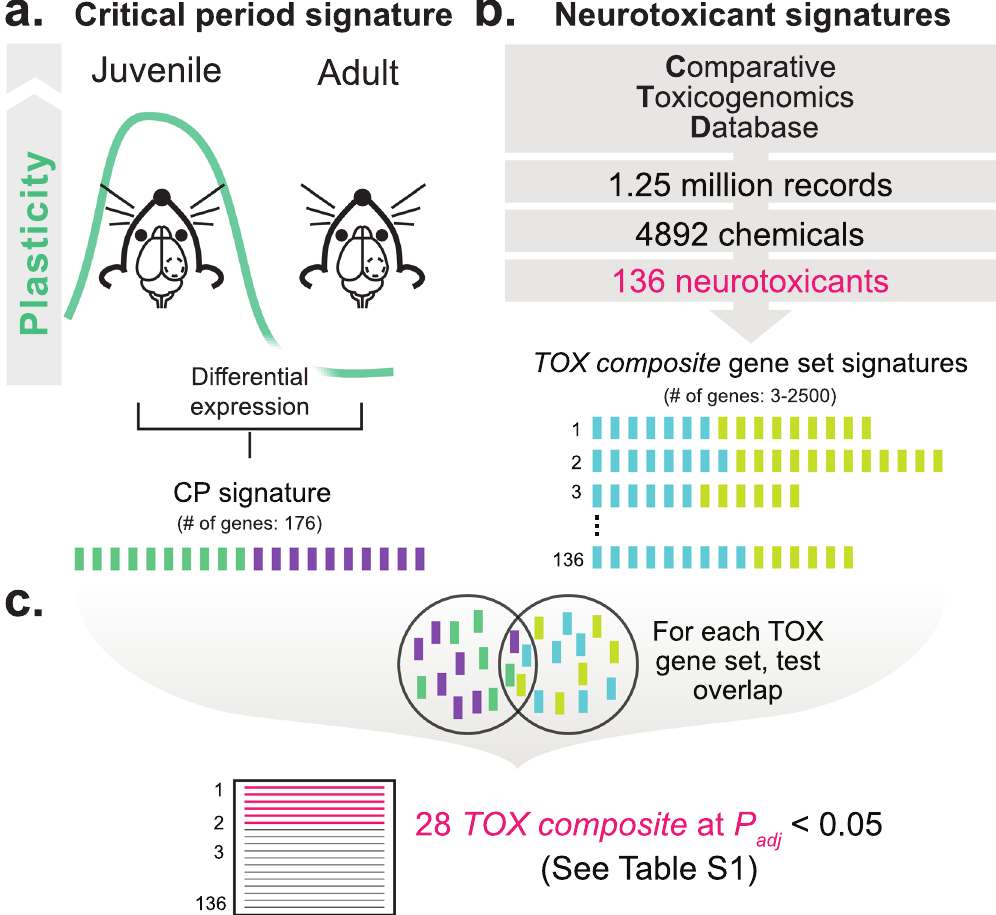
Figure 1. Generation and initial screening of neurotoxicant and critical period transcriptional signatures. ( a ) We generated a critical period signature by differential expression of primary visual cortex (V1) from mouse during the endogenous critical period at postnatal day (P) 26 compared to adult at > P56 using public data (GSE89757) to yield a 176 gene signature. ( b ) From 1.25 million Comparative Toxicogenomics Database (CTD) records across 4892 chemicals with mRNA relationships, we generated 136 neurotoxicant gene sets that included genes both increased or decreased by a given neurotoxicant ( TOX composite gene set; 3-2419 genes per set). ( c ) We used Hypergeometric tests to assess the likelihood of overlapping genes in the critical